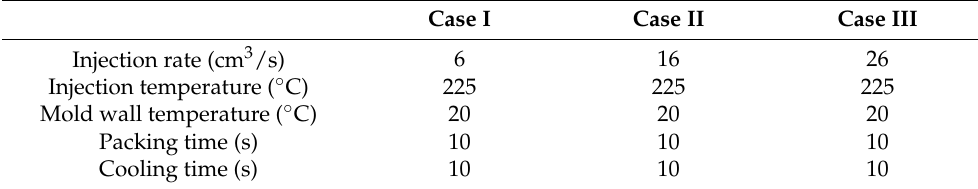
Table 6. Processing conditions for the droplet morphology experiment.